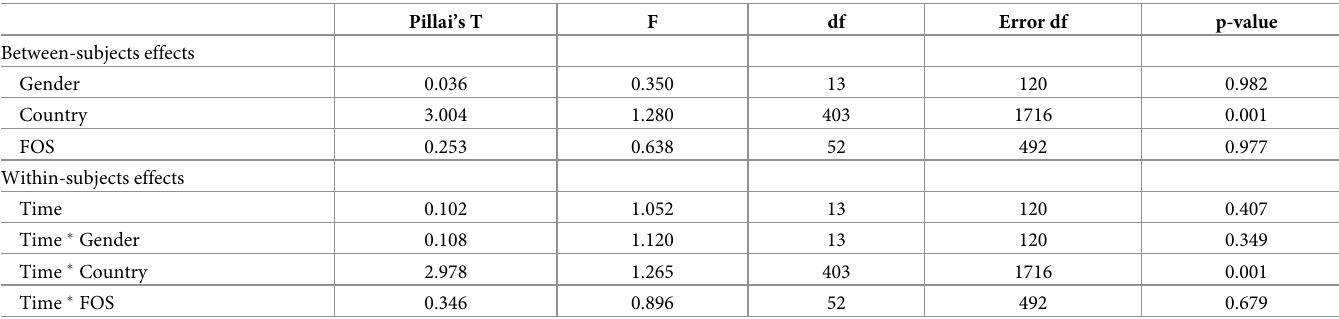
Table 4. Multivariate tests for the first and second pandemic semesters